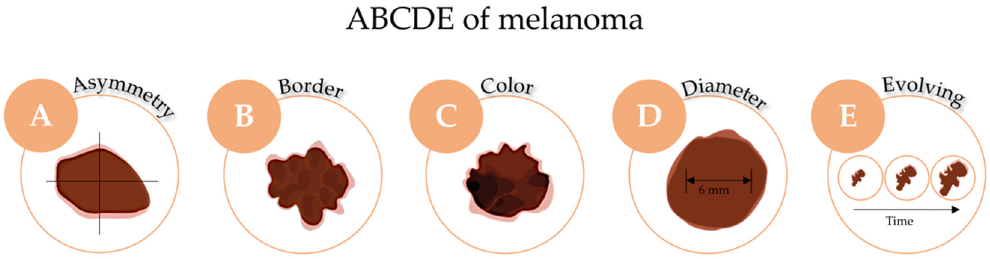
Figure 4. The ABCDE rule for melanoma skin cancer diagnosis.